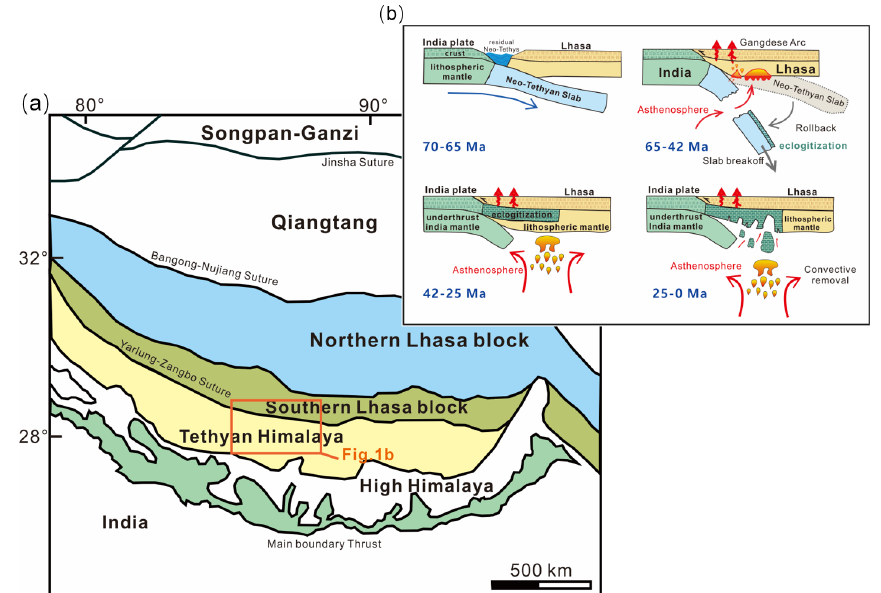
Figure 1. (a) Schematic geological map of the Tibetan Plateau (modified from Chung et al., 2005, and Wang et al., 2010). (b) Interpretive geological cartoon of India–Asia collision evolution. 70–65Ma: the flat Neo-Tethyan oceanic slab subducts beneath Tibet with the closure of the Neo-Tethys Ocean. 65–42Ma: the rollback of the Neo-Tethyan slab breaks off after densification by eclogitization. 42–25Ma: the subduction of the Indian continent continued at a low subduction angle beneath the Lhasa terrane and was accompanied by heavy thermal perturbation. 25–0Ma: the thickened eclogitic lower crust undergoes the “convective removal” of delamination due to gravitational instability.